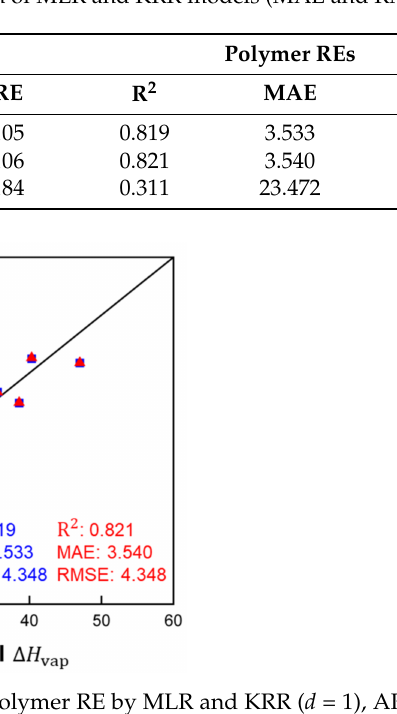
Table 3. Performance comparison of MLR and KRR models (MAE and RMSE in kJ/mol).